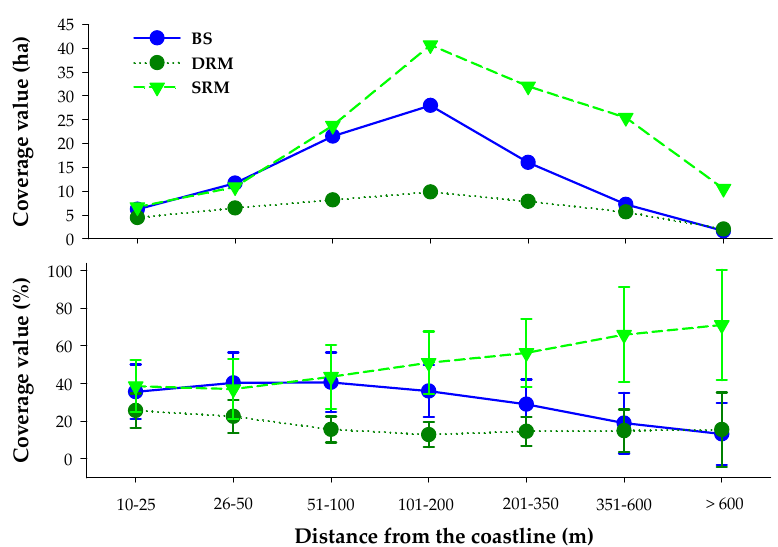
Figure 7. Spatial trends—expressed in terms of distance classes from the lake coastline—of the average cover values for 2017 ( upper graph expressed in terms of ha, lower graph expressed in terms of percentage) of the three bottom cover classes obtained by Bio-Optical Model-Based tool for Estimating water quality and bottom properties from Remote sensing images (BOMBER) algorithm.